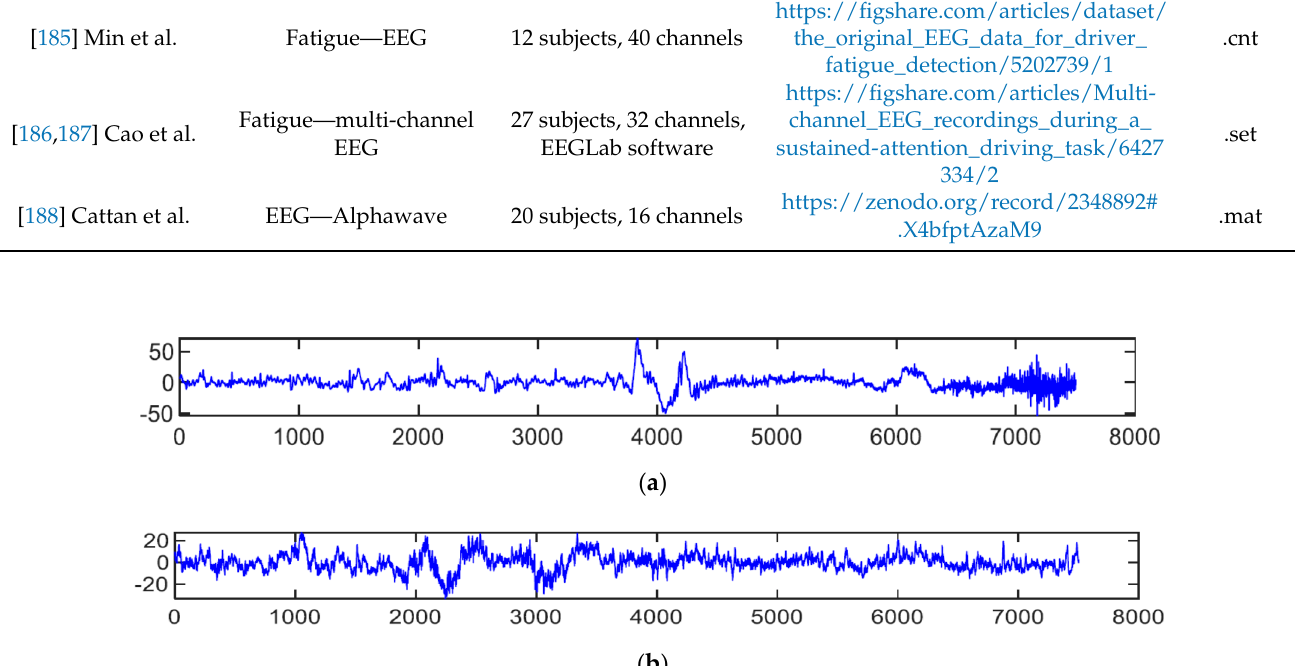
Figure 5. ( a )–( d ) Annotated images from multiview points, illumination and expressions (MultiPIE) datasets [181] and ( e ) examples from the ther Multimodal Verification for Teleservices and Security applications( XM2VTS) dataset with inaccurate annotations. Table 5. Online multi-sensors based datasets are available to train and test the network by using EEG sensors data. Cited